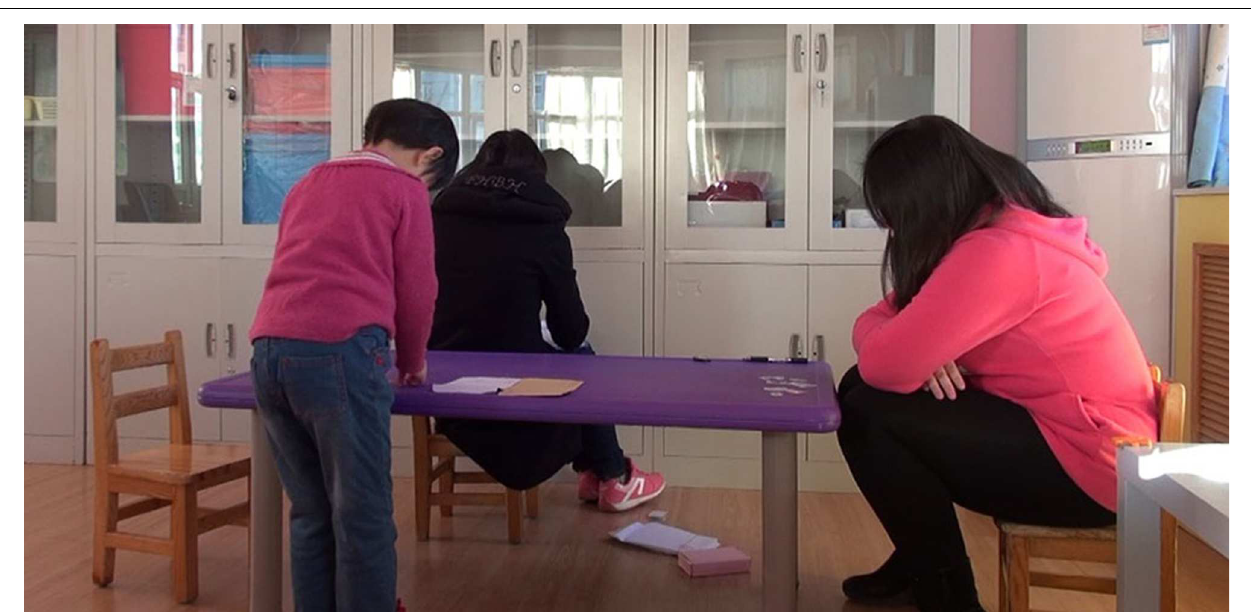
FIGURE 1 | A participant walked to the middle area to allocate stickers between herself and the partner (in red clothes), with the experimenter (in black clothes) turning her back around.